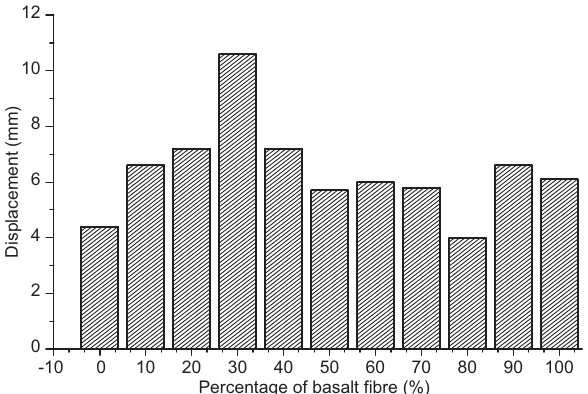
Figure 2 Rate of elongation during tensile